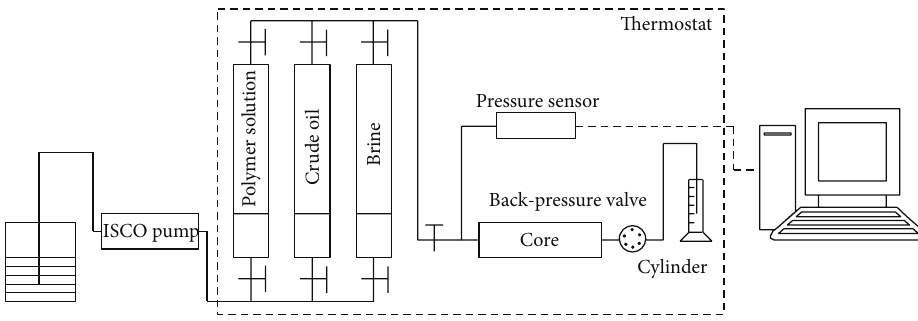
Figure 1: Flow chart of the core flooding tests.